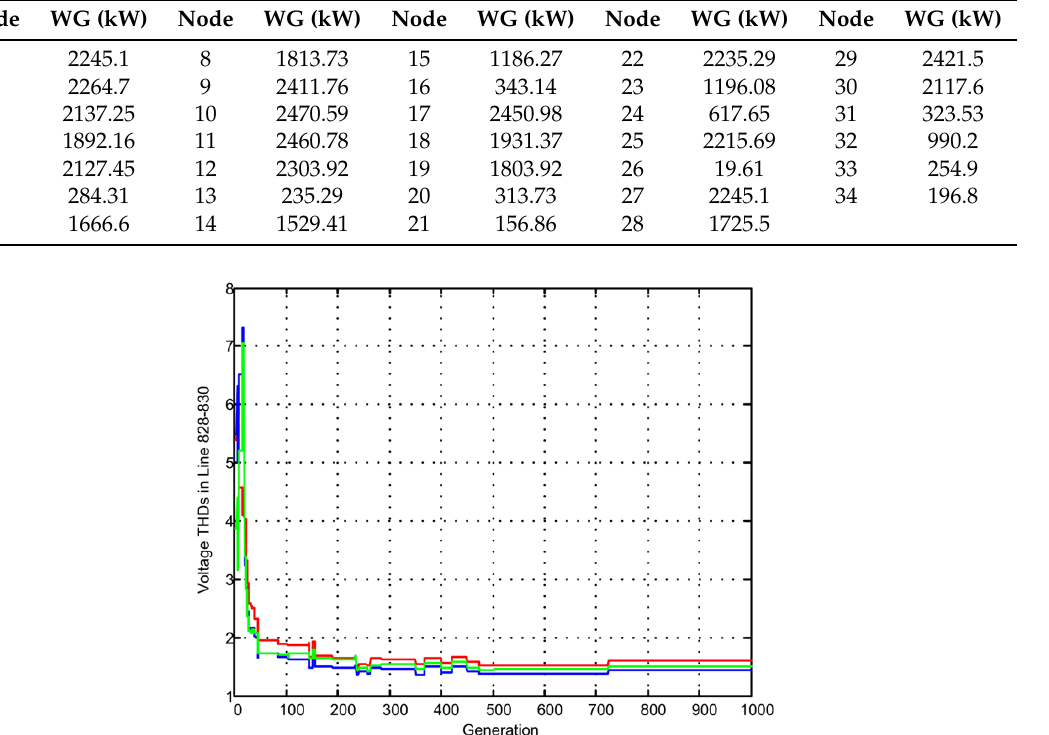
Table 10. Optimal WG Dispatch in High EV Penetration.